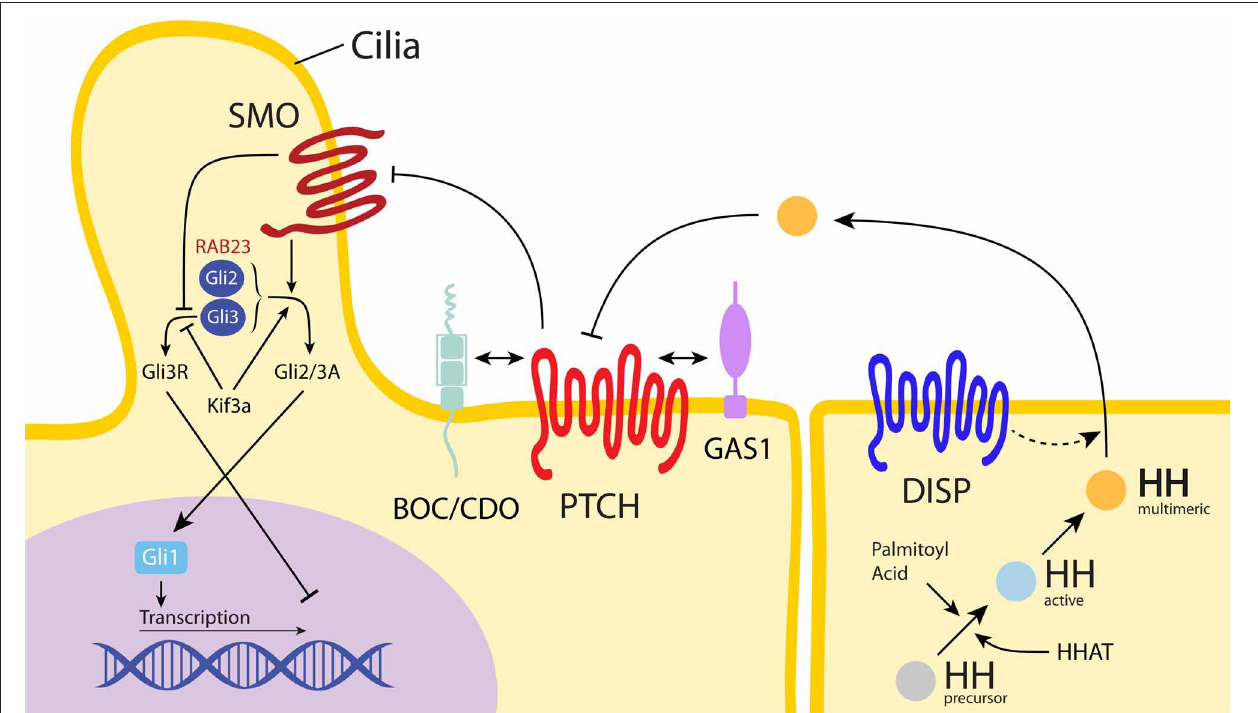
FIGURE 1 | Hedgehog pathway. The Hedgehog (HH) ligand precursor undergoes a series of modifications until reaching an active, multimeric form (shown in yellow). All three HH ligands then signal through the same pathway: following multimeric HH ligand release from Dispatched (DISP) and secretion from the signaling cell, the HH ligand binds to Patched (PTCH) on the receiving cell, releasing Smoothened (SMO) from constitutive inhibition (Cohen, 2003). Released SMO then shuttles through the cilia. This signals activation of the Gli2/3 complex (shown as Gli2/3A), which promotes gene expression via Gli1, while simultaneously inhibiting the Gli3 repressor form (shown as Gli3R). In the presence of HH activated SMO, the Kif3a motor complex promotes Gli2/3A expression and inhibits